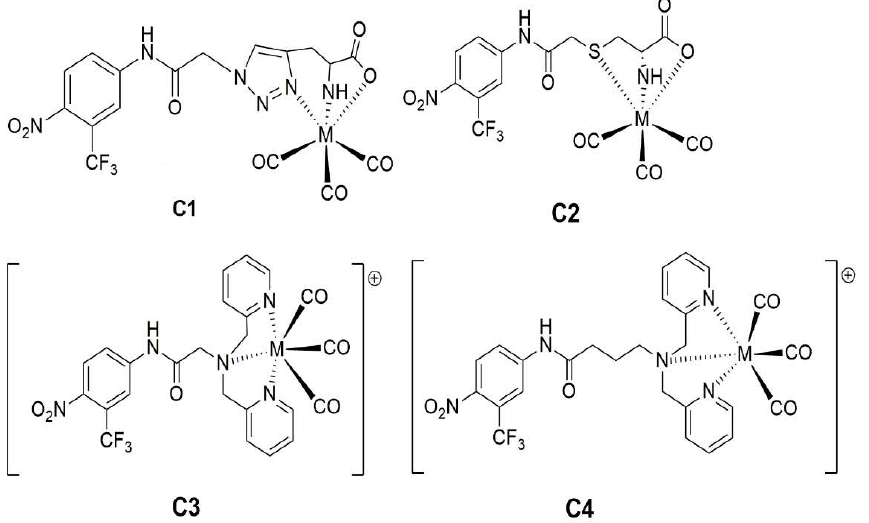
Figure 3. Proposed structures of 99m Tc and Re complexes prepared from Ligands L1 – L4 (M is either 99m Tc or Re).